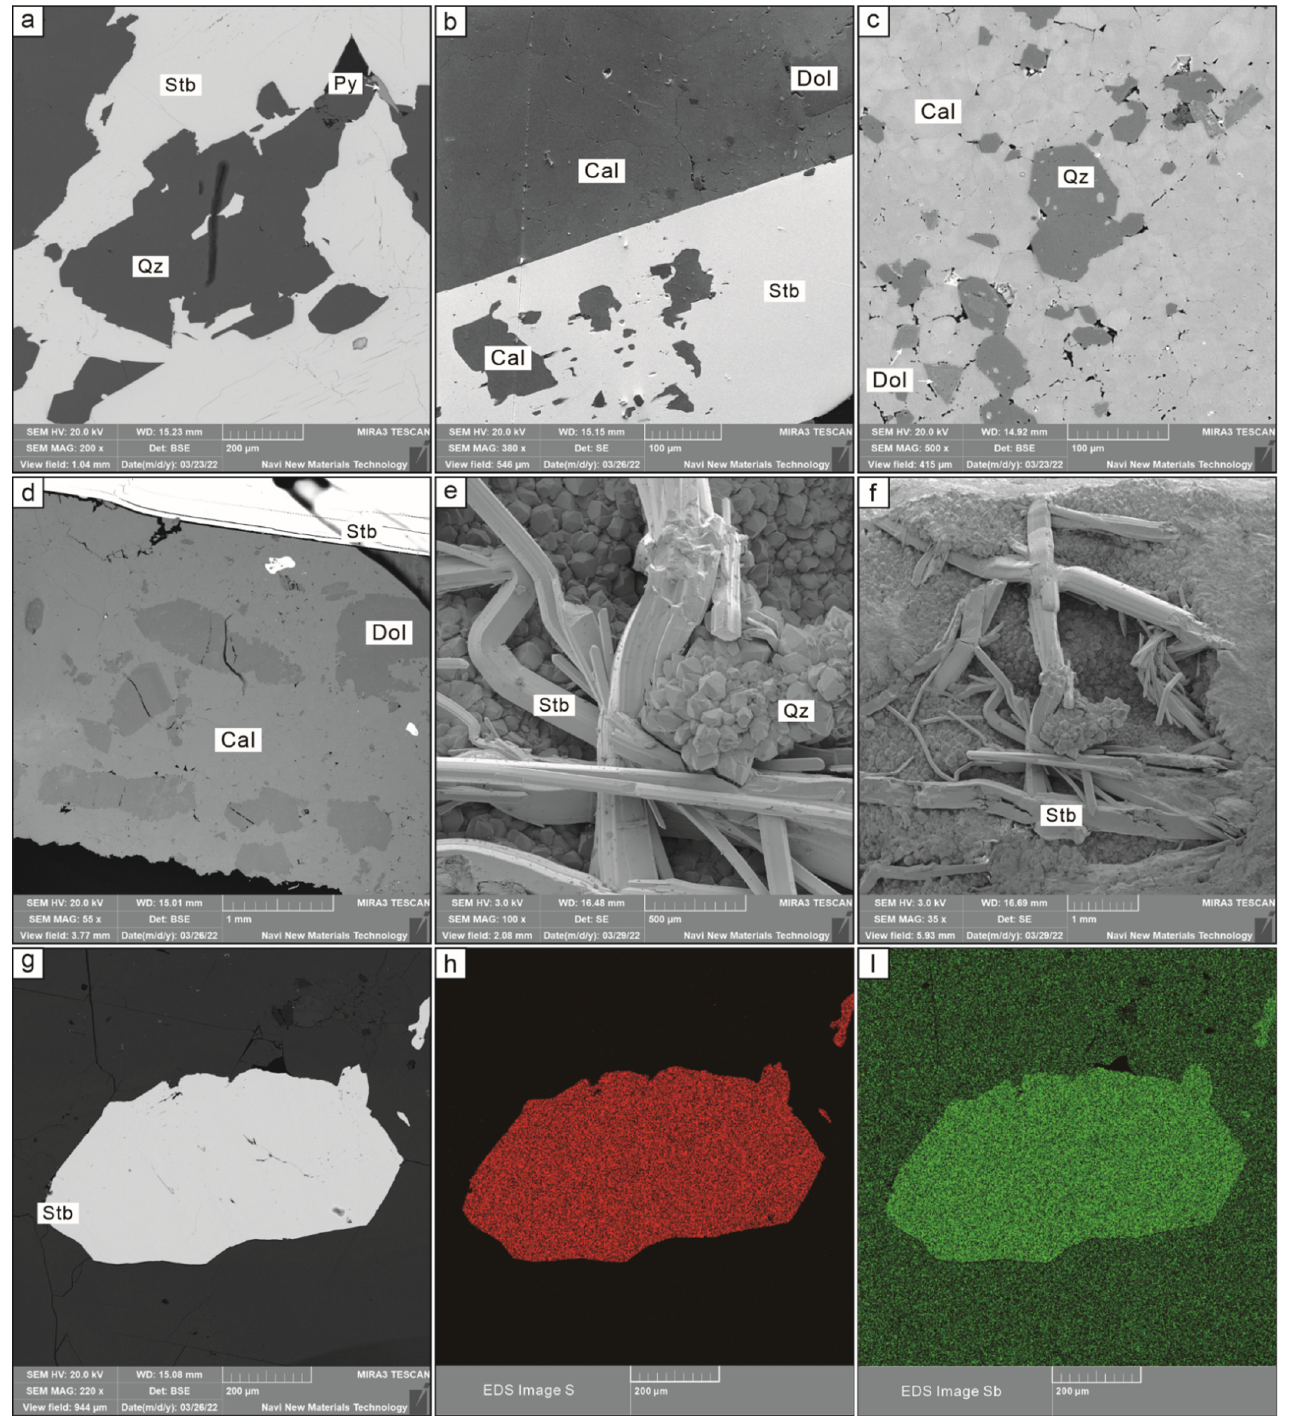
Figure 6. Scanning electron microscopy images of the Daocaowan Sb deposit. ( a ) Pyrite growing in quartz–stibnite ores; ( b , d ) Dolomite growth in calcite–stibnite ore; ( c ) Quartz–calcite–stibnite ores showing the association between calcite and quartz; ( e , f ) Quartz and stibnite in crystal cavity; ( g – i ) Energy spectrum scanning of stibnite showing that there is no obvious structure in stibnite particles.